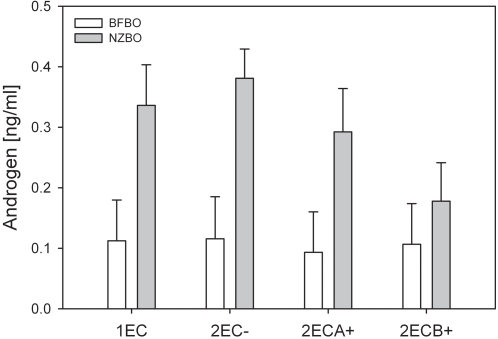
Mean (±95% CI) androgen level in Nazca booby (NZBO) and blue-footed booby (BFBO) hatchlings.1EC = products of one-egg clutches, 2EC- = products of two-egg clutch where only one egg hatched, 2ECA+ = first hatchling from two-egg clutch where both eggs hatch, 2ECB+ = second hatchling from two-egg clutches where both eggs hatch.